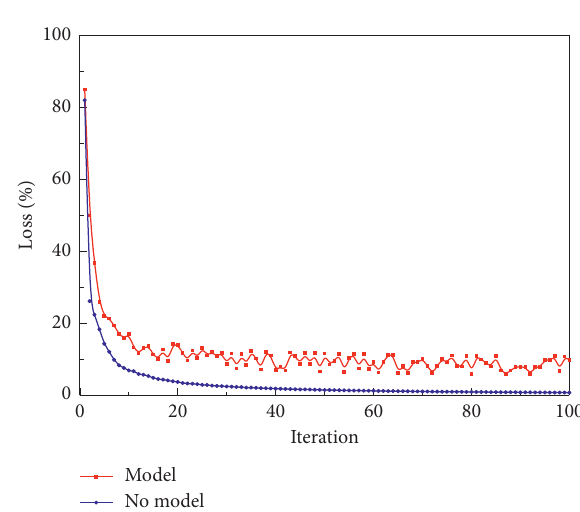
Figure 6: The model’s two-stage training